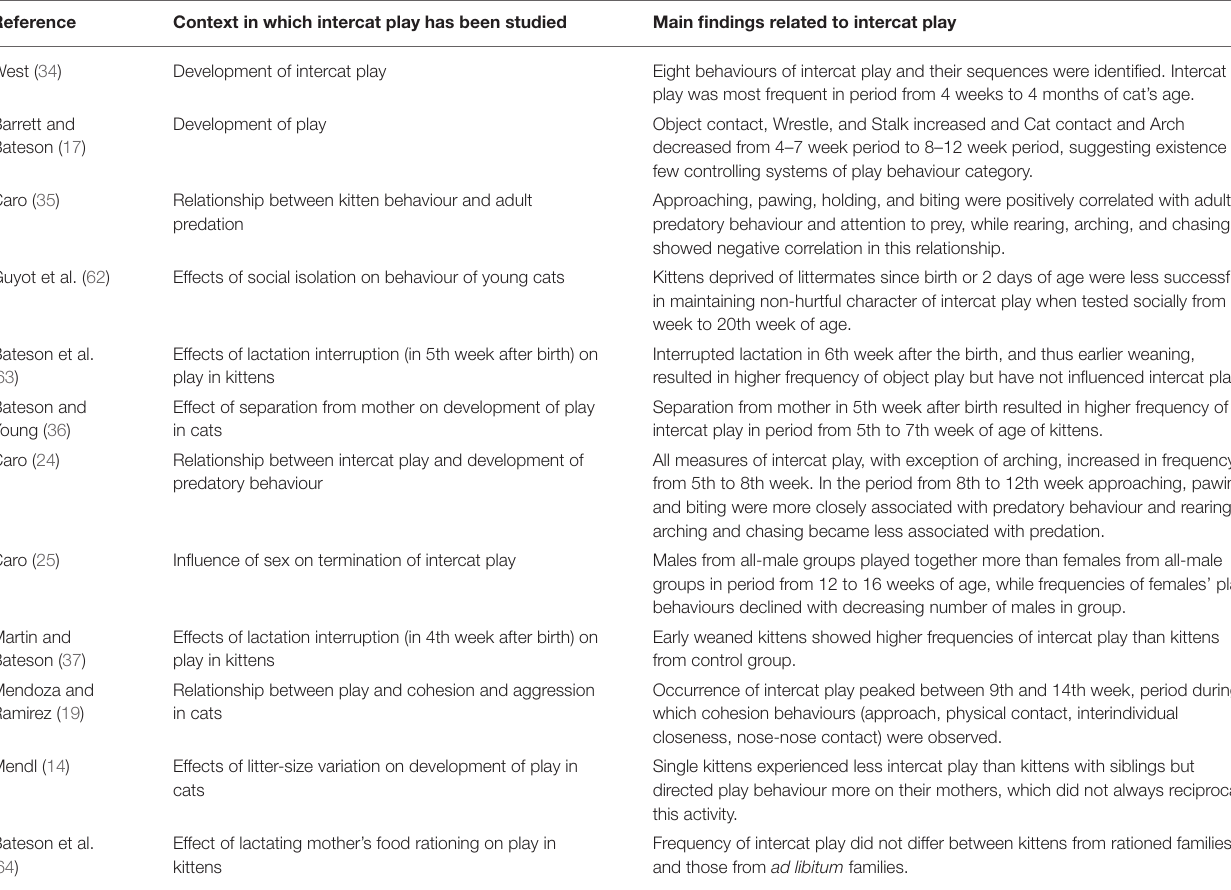
TABLE 2 | Overview of main findings from observational studies of intercat play.